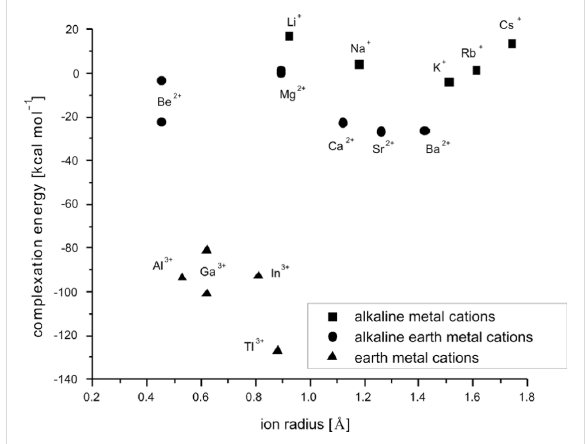
Figure 10: RB3LYP/LANL2DZp complexation energies for [M 2.2.bpy] m+ according to Scheme 1, plotted against the ionic radius of M m+ ; for the data see Table 3.